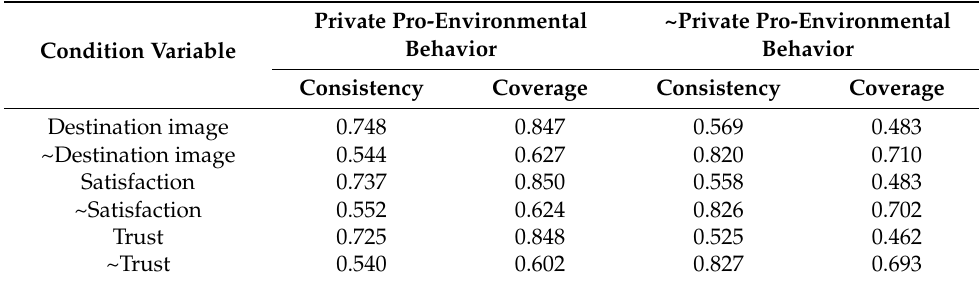
Table 10. Analysis of necessary conditions in private pro-environmental behavior